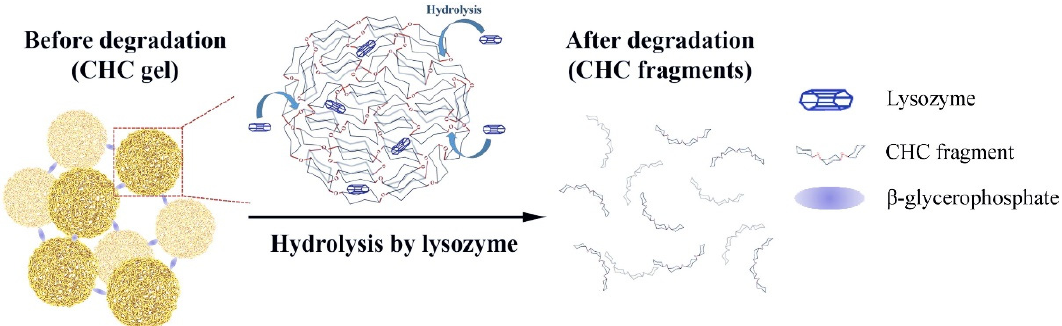
Figure 6. Illustration of lysozyme-dependent CHC gel degradation and insulin release. Adapted with permission from [48]; Published by Elsevier, 2016.